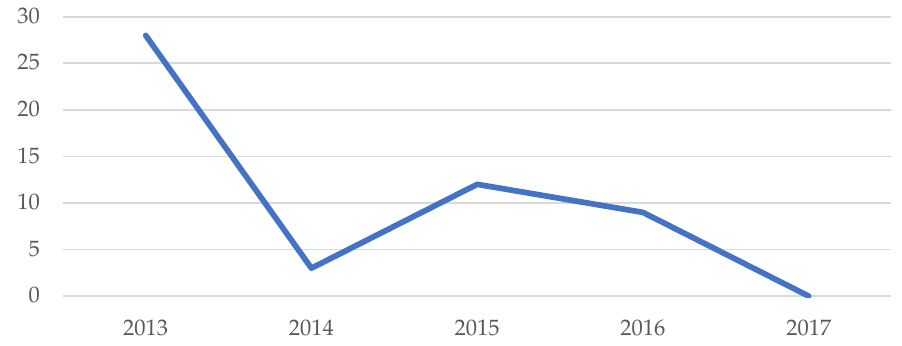
Figure 6. Numbers of forest fires. Source: Reproduced with permission from Dak Lak Provincial Forest Protection and Development Fund [60].